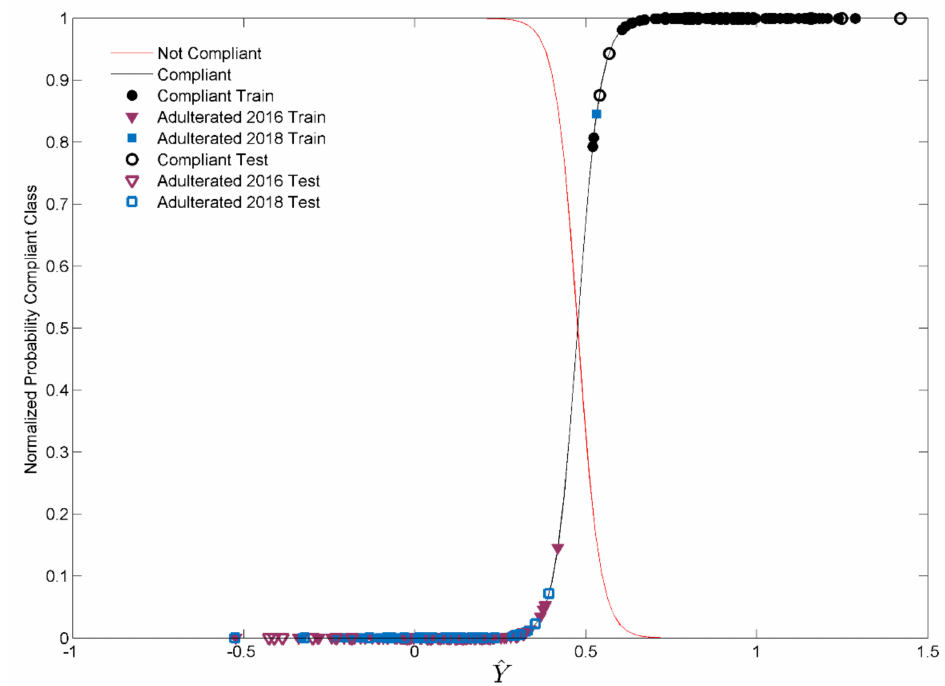
Figure 5. Normalized probability of the Compliant class (black curve) and posterior probability of training (full symbols) and test samples (empty symbols) for Model